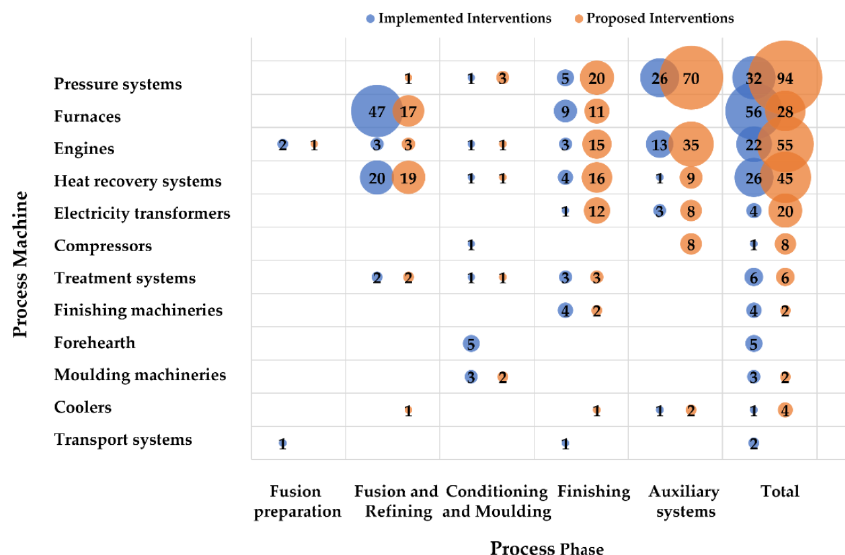
Figure 5. Interventions implemented and proposed for different process machines.